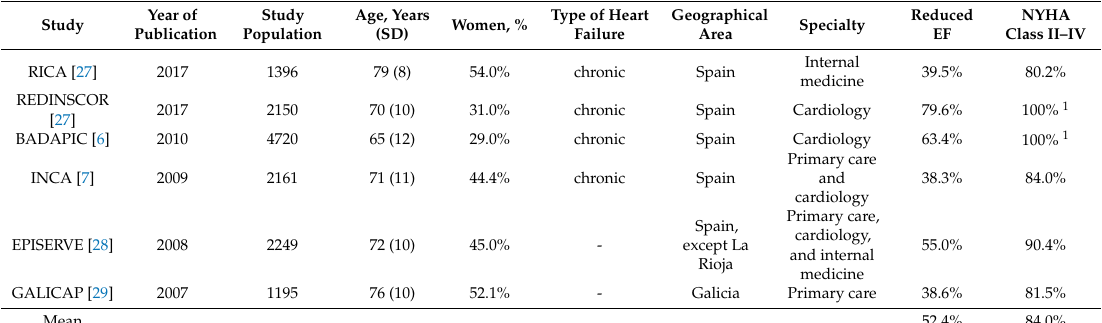
Table 3. Studies of patients with heart failure in